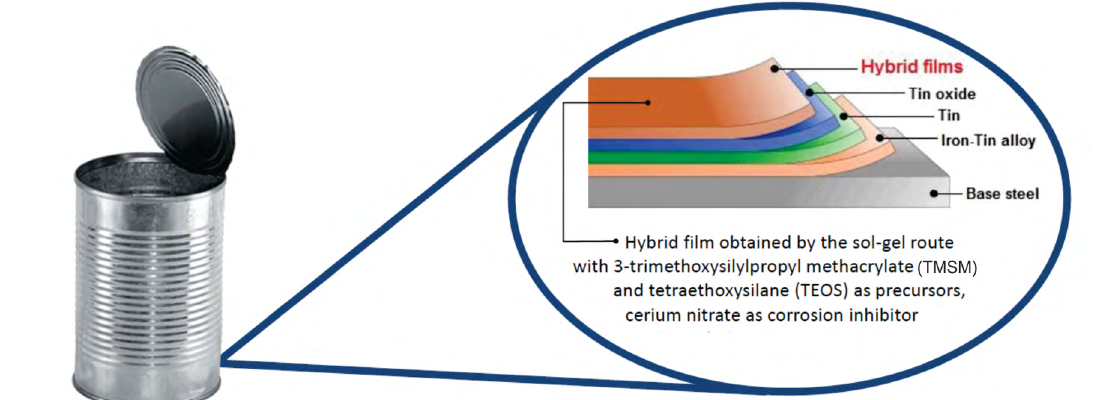
Figure 1. Illustrates system showing the layers obtained from the iron-base to the top